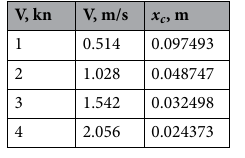
Table 3. Estimated Transition Point x c with varying flow velocity V.